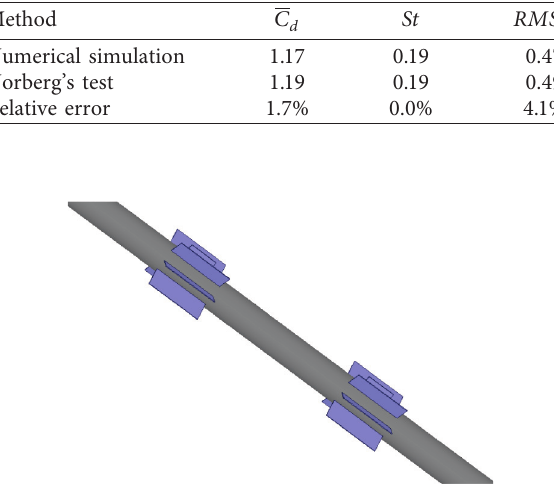
Figure 6: The calculation model with two spoilers.